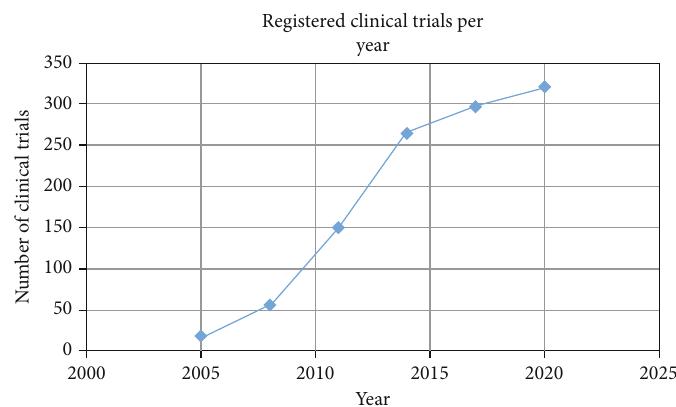
Figure 3: Variations of the number of registered clinical trials through the years at Clinicaltrials.gov.